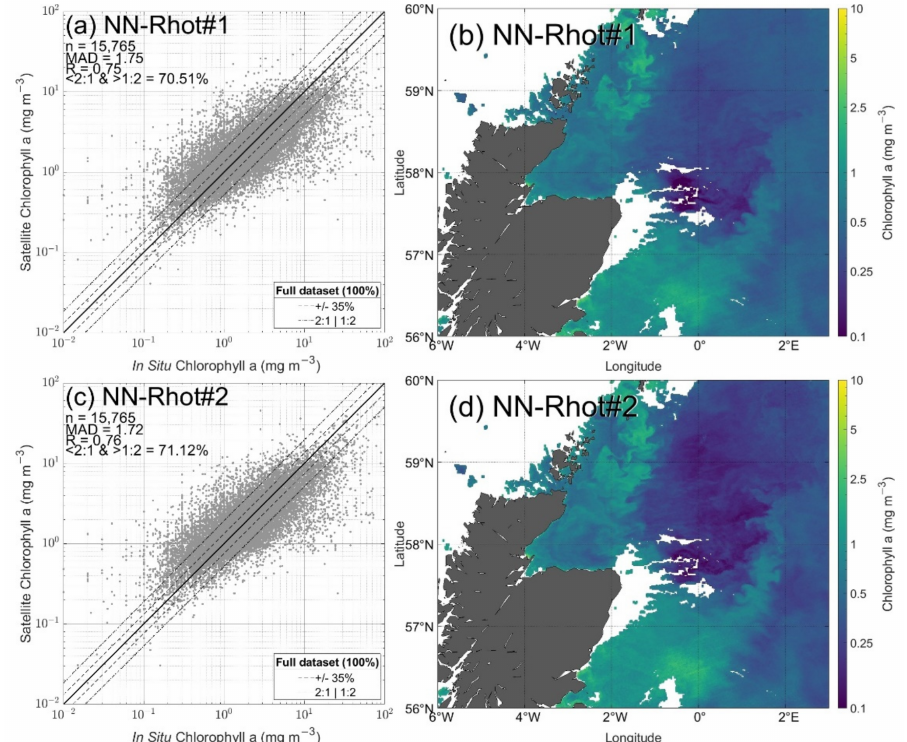
Figure 6. Two examples of the same architecture of a Rhot neural network using 3 layers of 15 neurons showing slight differences. ( a , c ) Neural network performances for the whole matchup data set. ( b , d ) Image of the 23 July 2019, 12:25 from MODIS-Aqua (same as Figure 7). Notice the difference around 0 ◦ E and 57.5 ◦ N coming from a coccolithophore bloom returning very low Chl